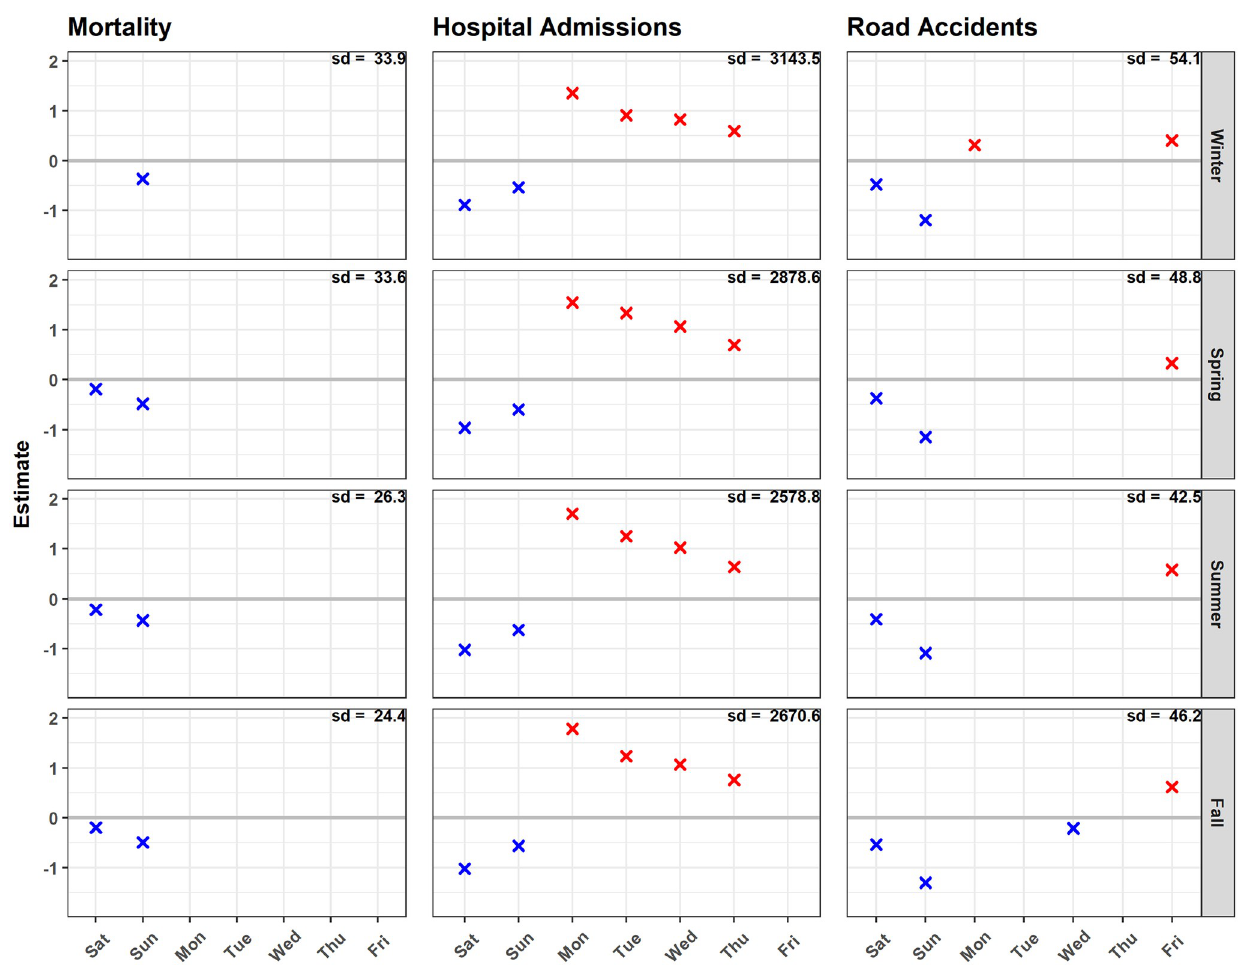
Fig 7. Day of the week effect. Day of the week effect on daily mortality, hospital admissions, and road accidents for each season, expressed in proportion of the standard deviations of daily number of cases within Bavaria compared to a reference day of the week (mortality Wednesday, hospital admissions Friday, road accidents Thursday). The color indicates the effect direction whether positive (red) or negative (blue). The number in the upper right corner of each panel indicates the standard deviation of daily cases in the relevant season for the whole of Bavaria. The absence of the cross means that the effect of the day was not significant in the corresponding model. Explanatory example: For winter hospital admissions, the sd is 3143.5, and the Saturday effect for Bavaria is -0.884. This indicates a decrease in daily hospital admissions by 0.884 � 3143.5 = 2779 on Saturdays compared to Fridays.